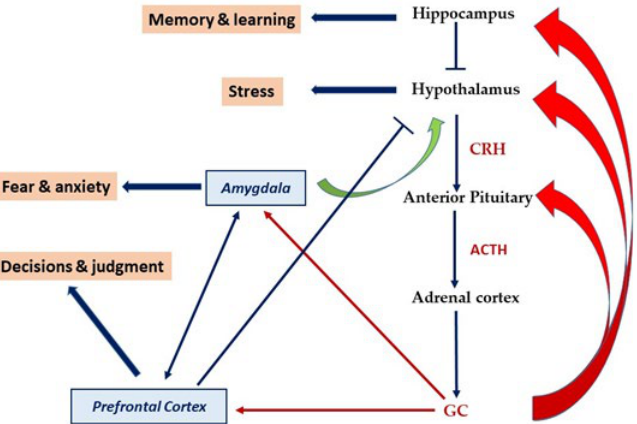
Figure 3. HPA axis. This figure represents the HPA axis or the stress axis where glucocorticoids (GCs) are the outcome of its activation. GC exerts feedback at the levels of the anterior pituitary, hypothalamus, and hippocampus to regulate the stress response. GC receptors are expressed in the hippocampus, hypothalamus, prefrontal cortex, and amygdala, which are considered part of the limbic system. CRF/CRH: corticotropin-releasing hormone or factor, ACTH: adrenocorticotropin hormone, GC: glucocorticoid. Red arrows on the right side mean negative feedback. Green arrow means positive feedback.